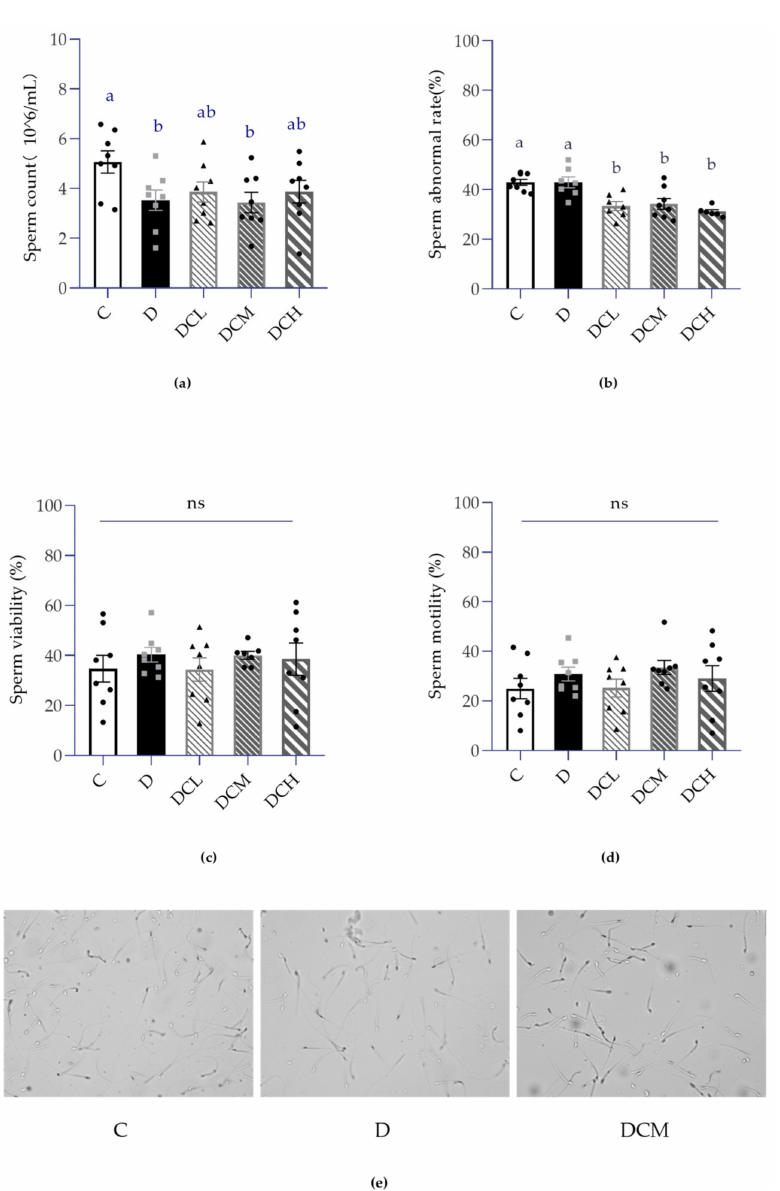
Figure 3. Semen parameters in mice with ulcerative colitis (ns, non-significant; Control, C; DSS- treated mice, D; DSS-C3G (12.5 mg/kg), DCL; DSS-C3G (25 mg/kg), DCM; DSS-C3G (50 mg/kg), DCH). ( a ) Sperm count per milliliter (106/mL), n = 8. ( b ) Sperm abnormal rate (%), n = 6~8. ( c ) Sperm viability (%), n = 8. ( d ) Sperm motility (%), n = 8. ( e ) Representative images of sperm capture. (cid:78) • (cid:4) : The number of symbols was consistent with the number of samples, and the relative position represented the degree of data dispersion. Results were represented as mean ± SEM. Parameters marked by the same alphabet are not significantly different. Significance is expressed as p <